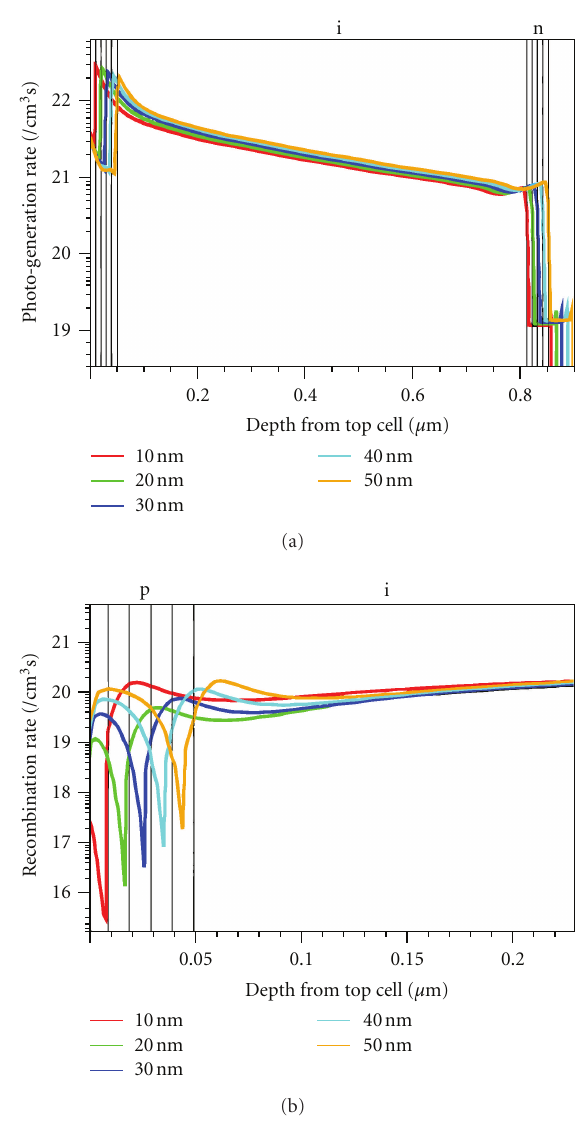
Figure 7: Photogeneration rate and recombination rate of The a- SiGe:H solar cell device for di ff erent thickness of